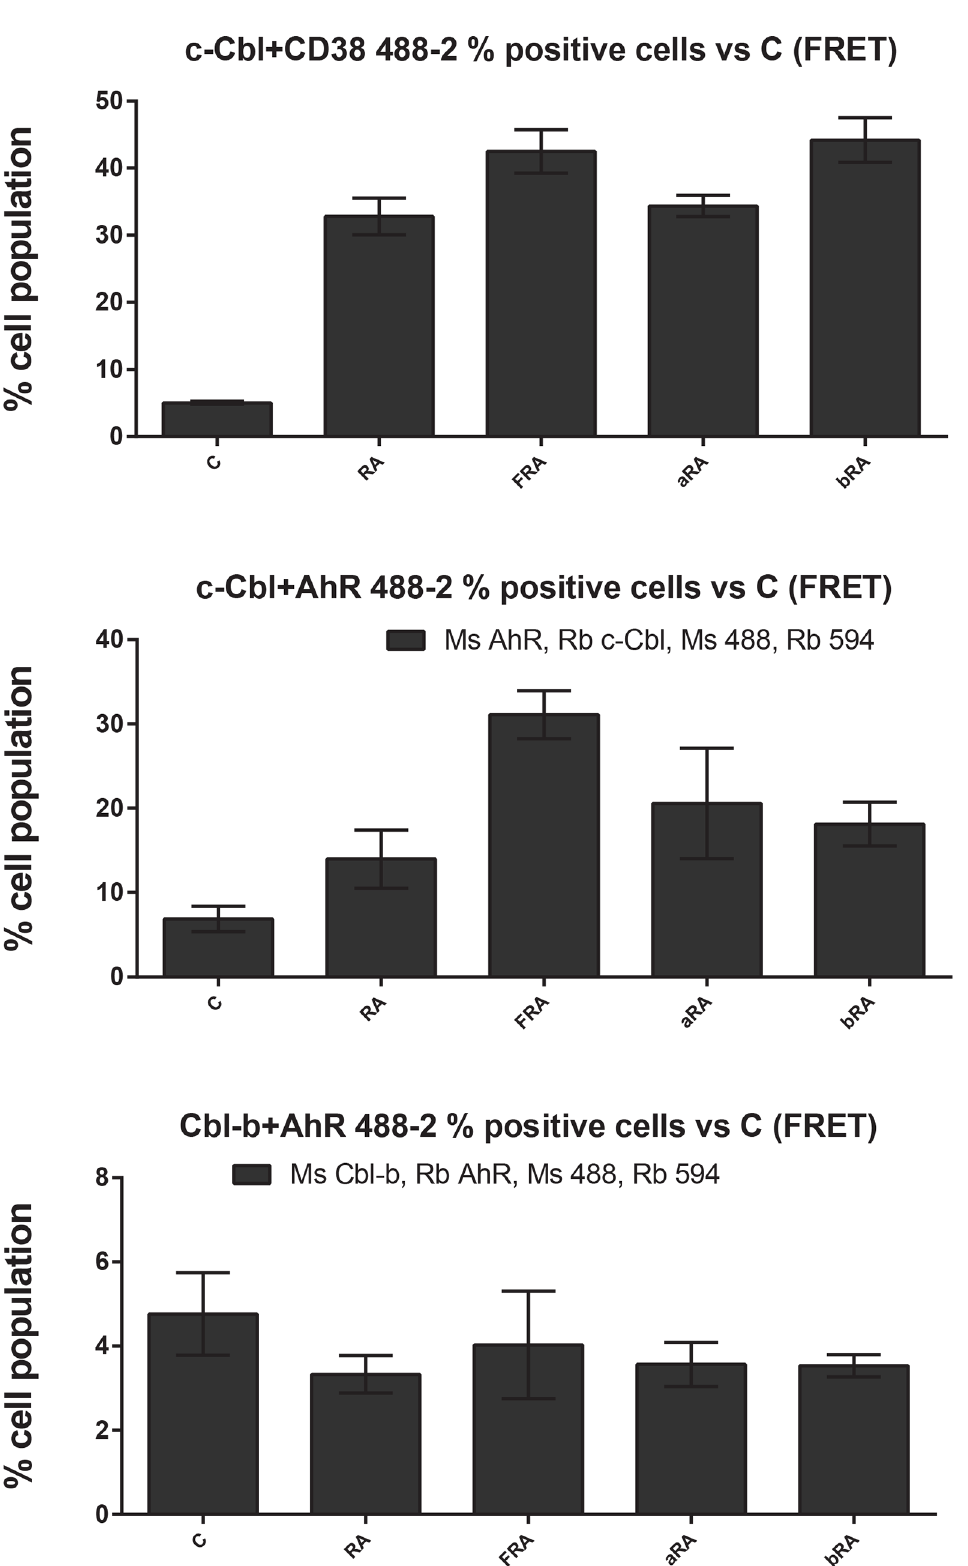
Fig 10. FICZ induces a c-Cbl-AhR association (percentage of positive cells). Percentage of positive cells, setting the control at 5% positive, from data described in Fig 9 is shown. doi:10.1371/journal.pone.0135668.g010 PLOS ONE | DOI:10.1371/journal.pone.0135668 August 19,